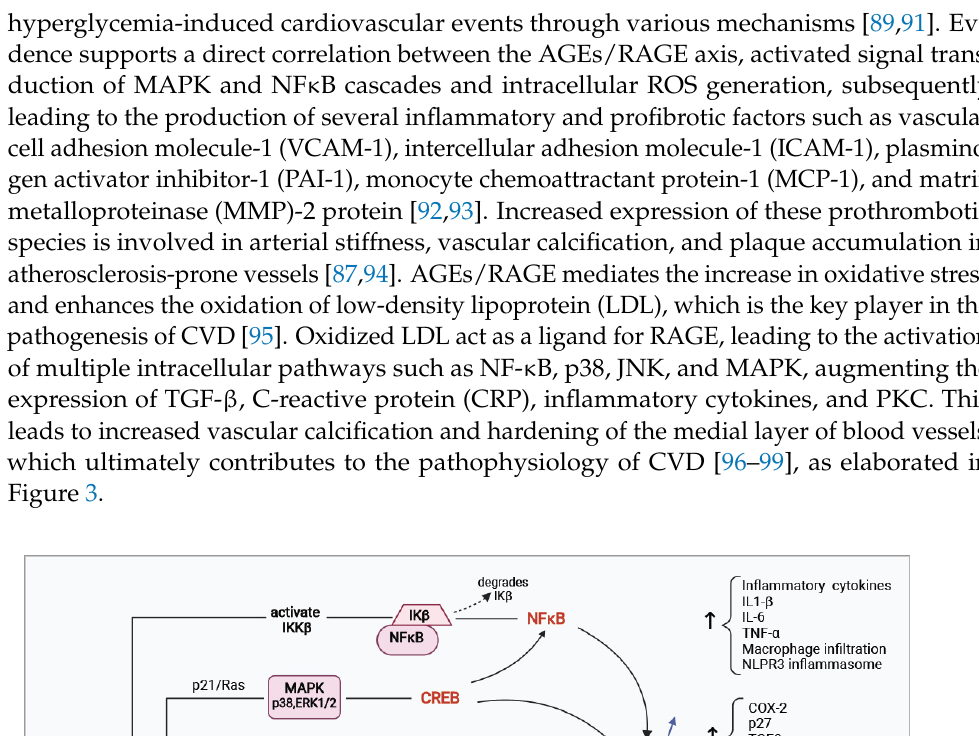
sponse element binding protein; PKC: protein kinase C; JNK: Jun N -terminal kinase; AP-1: activator protein 1; JAK-STAT: janus kinase-signal transducer and activator of transcription.